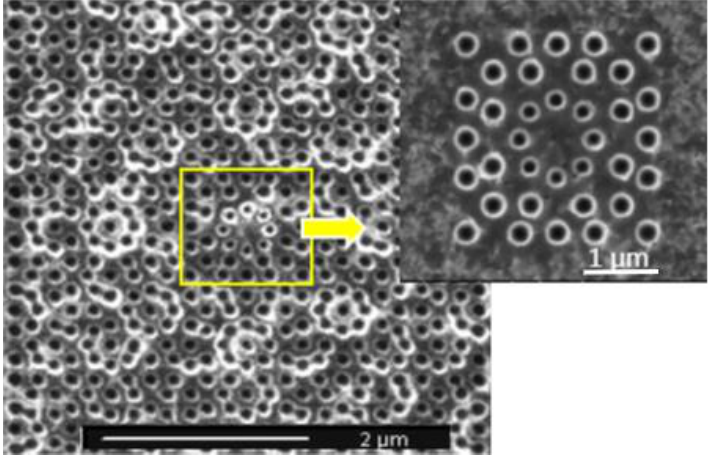
Figure 5. SEM image of quasicrystal structure.